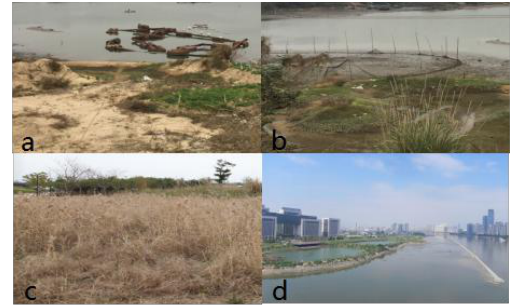
Figure 2. Different types of wetlands.